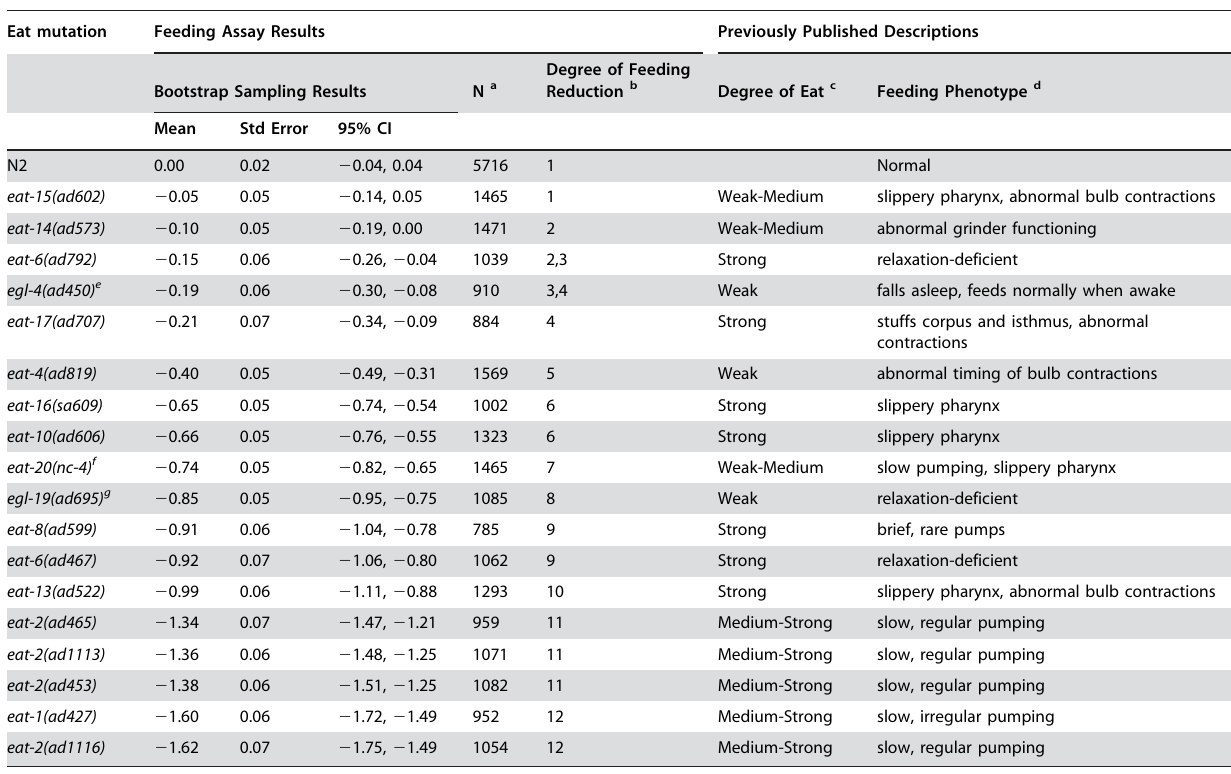
Table 1. Effects of Eat Mutations on C. elegans Feeding .. ... .... ... ... .... ... ... .... ... ... .... ... ... .... ... ... .... ... ... .... ... ... .... ... ... .... ... ... .... ... ... .... ... ... .... ... ... .... ... ... .... ... ... . Eat mutation Feeding Assay